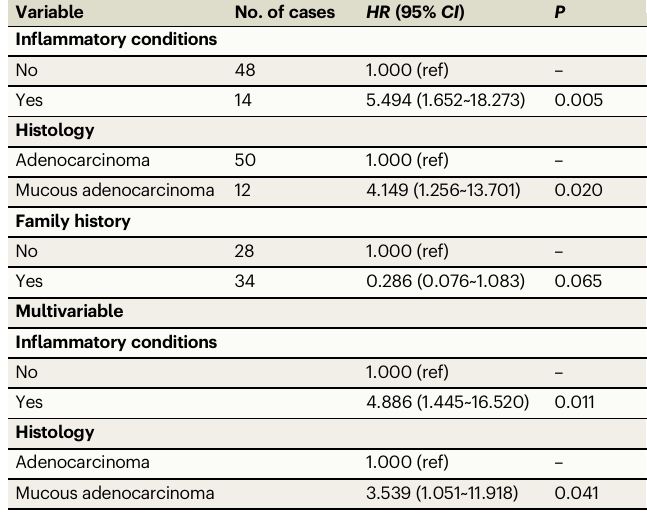
Table 1 | Baseline characteristics of 62 MSI-H CRC patients receiving PD-1